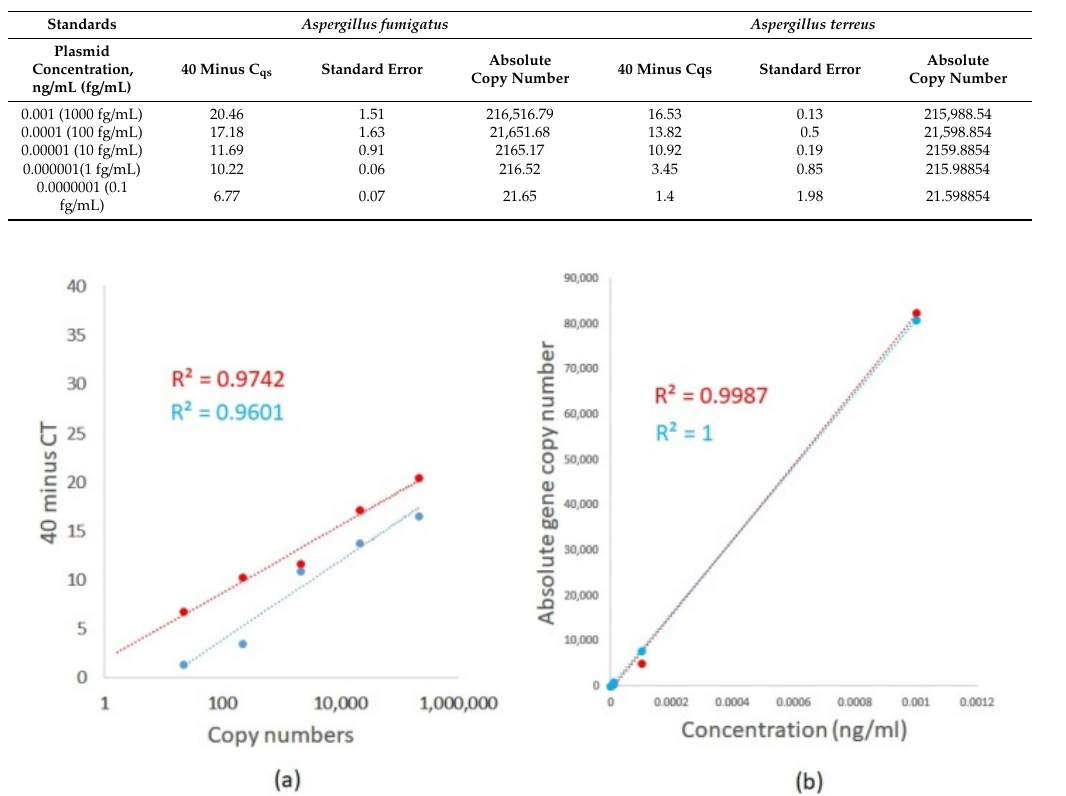
Table 2. Table illustrating plasmid concentration, expected absolute plasmid copy number and